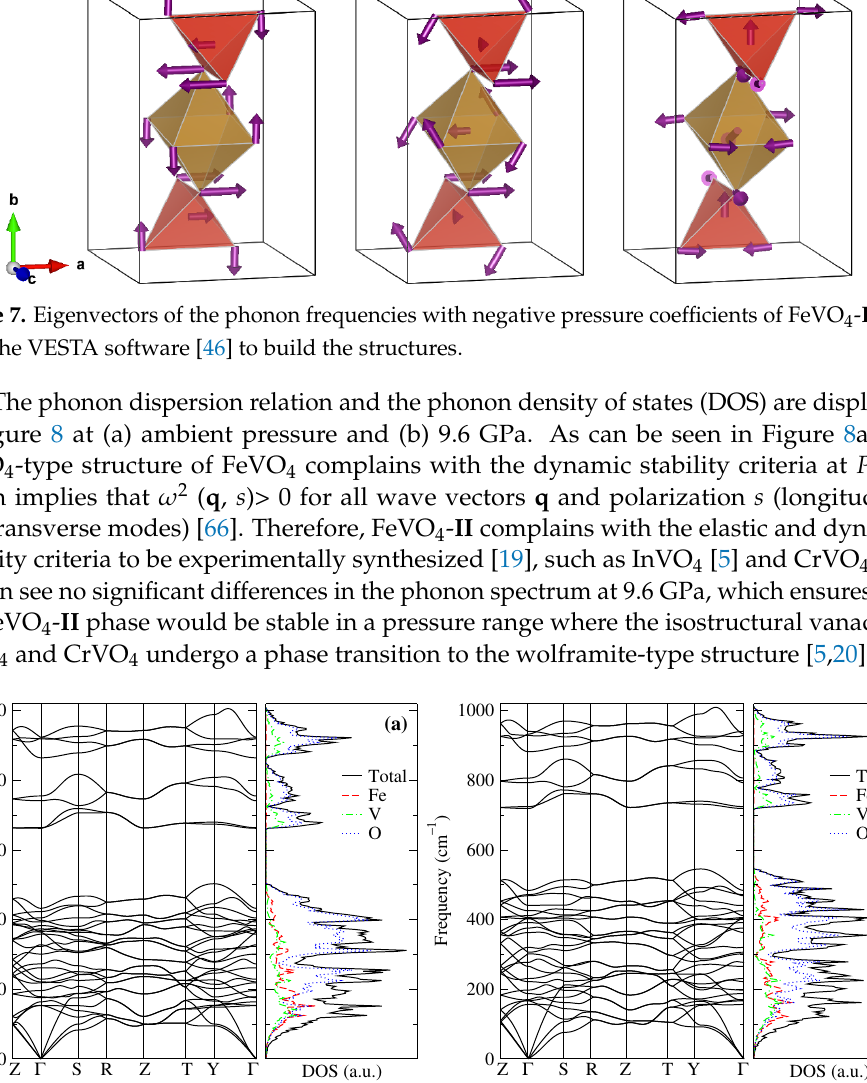
Figure 8. Phonon spectrum and phonon DOS at ( a ) 0 GPa, and ( b ) 9.6 GPa of FeVO 4 - II